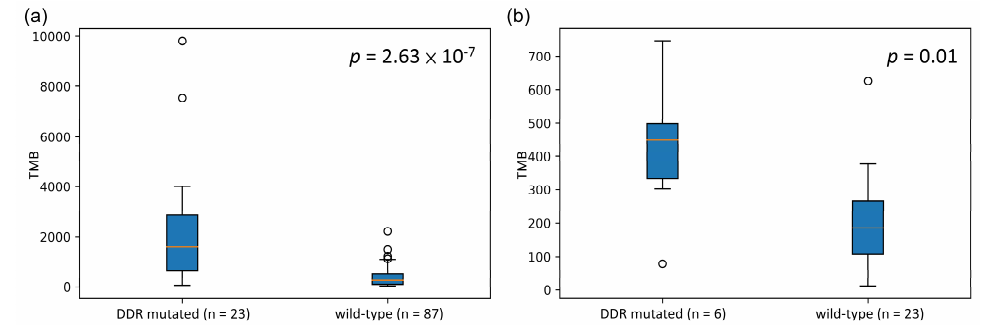
Figure 3. Boxplot of TMB distribution in both the mutated and wild-type groups for SKCM and LUAD: ( a ) SKCM and ( b ) LUAD. p -value was calculated by the Mann–Whitney U test.